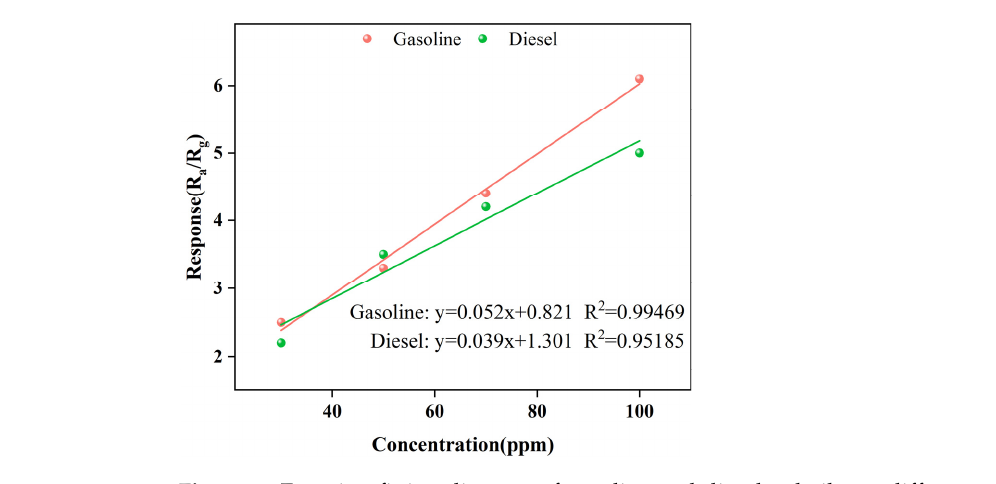
Figure 6. Function-fitting diagram of gasoline and diesel volatiles at different concentrations by Gd 0 . 5 In gas sensor at 250 ° C.